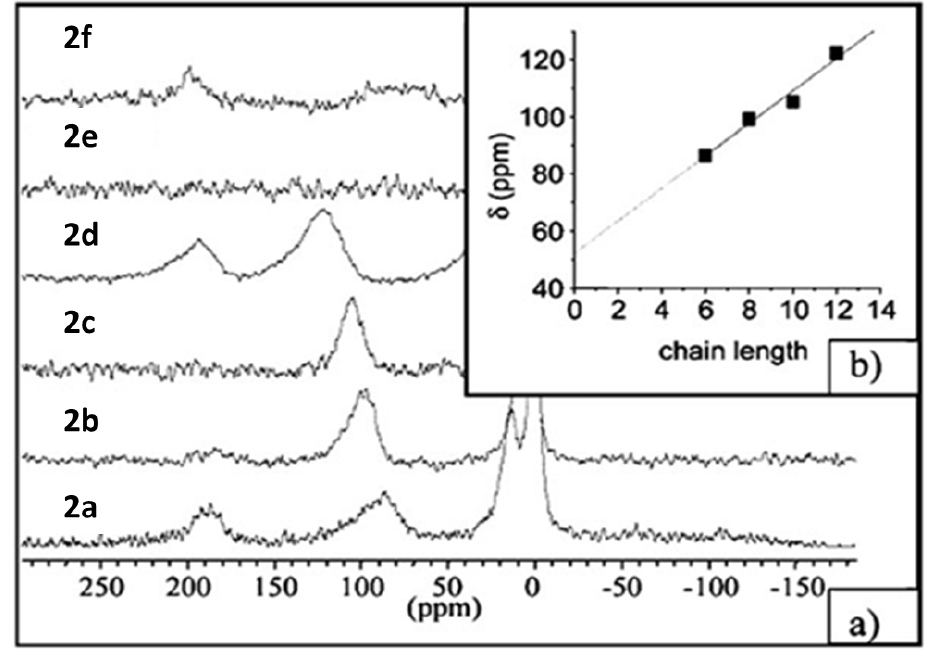
Figure 7. ( a ) Static 129 Xe NMR spectra recorded under continuous flow of hyperpolarized xenon at an effective Xe pressure of 7 Torr and T 293 K; ( b ) Plot of the chemical shift of Xe in the host cavity versus the chain length of the amphiphilic calixarenes